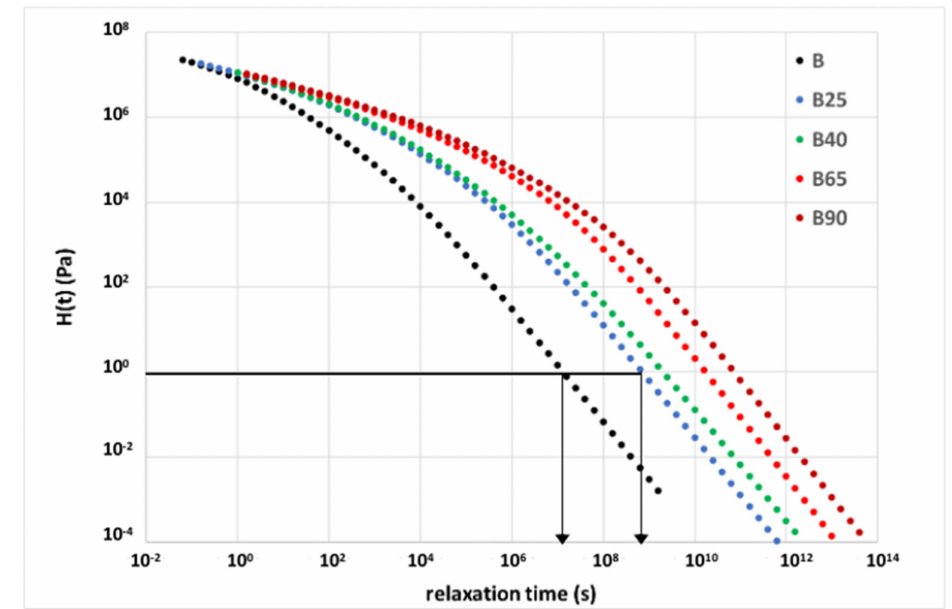
Figure 12. Relaxation spectra for binder B at all investigated levels of aging.